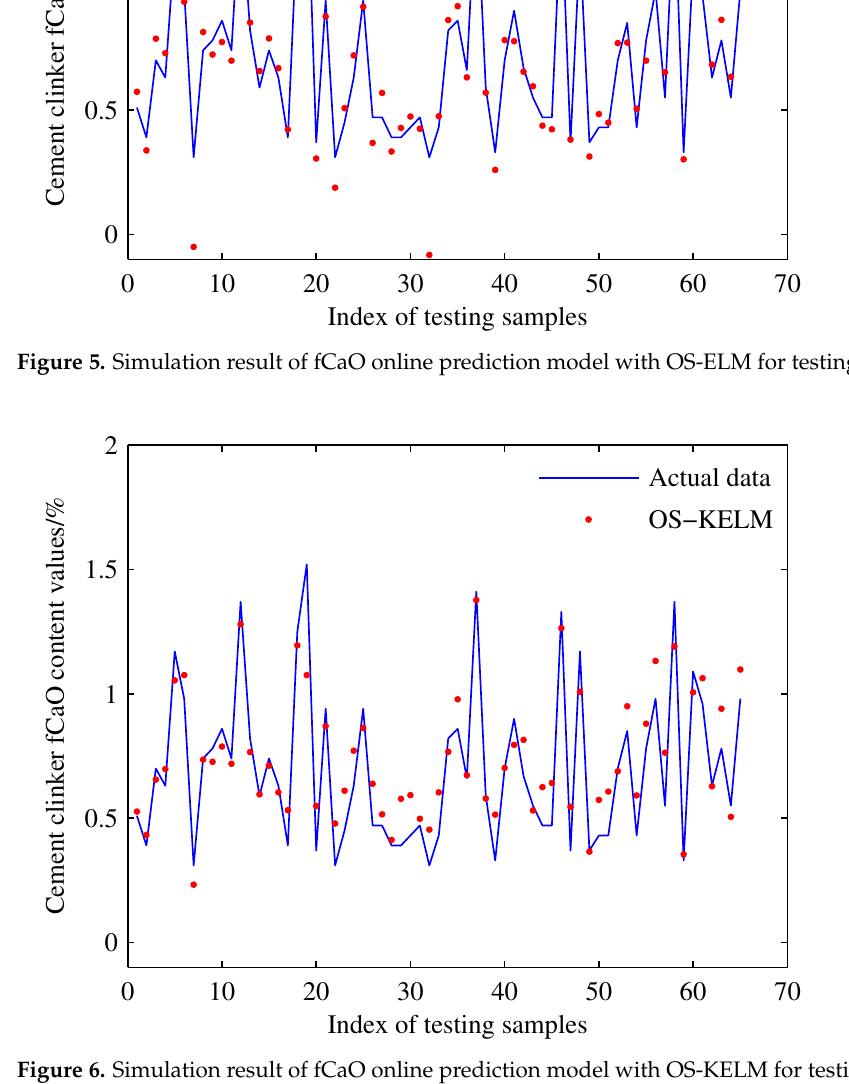
Figure 6. Simulation result of fCaO online prediction model with OS-KELM for testing